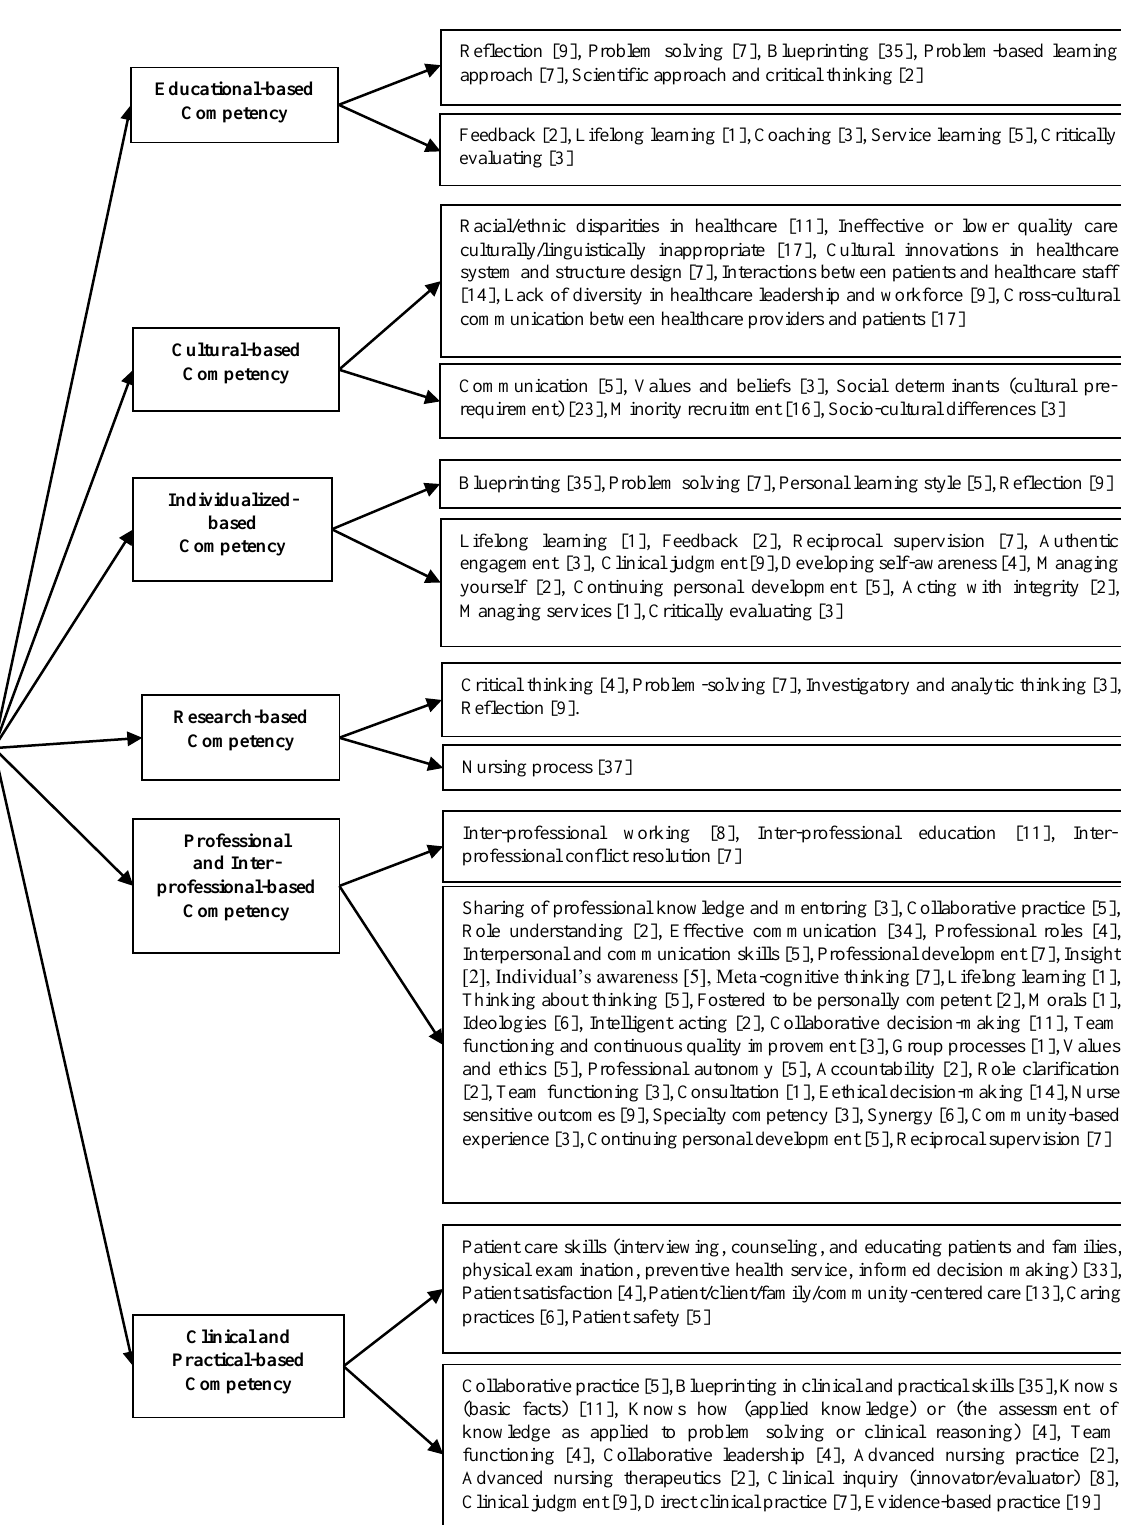
Figure 2. Domains of nursing students'